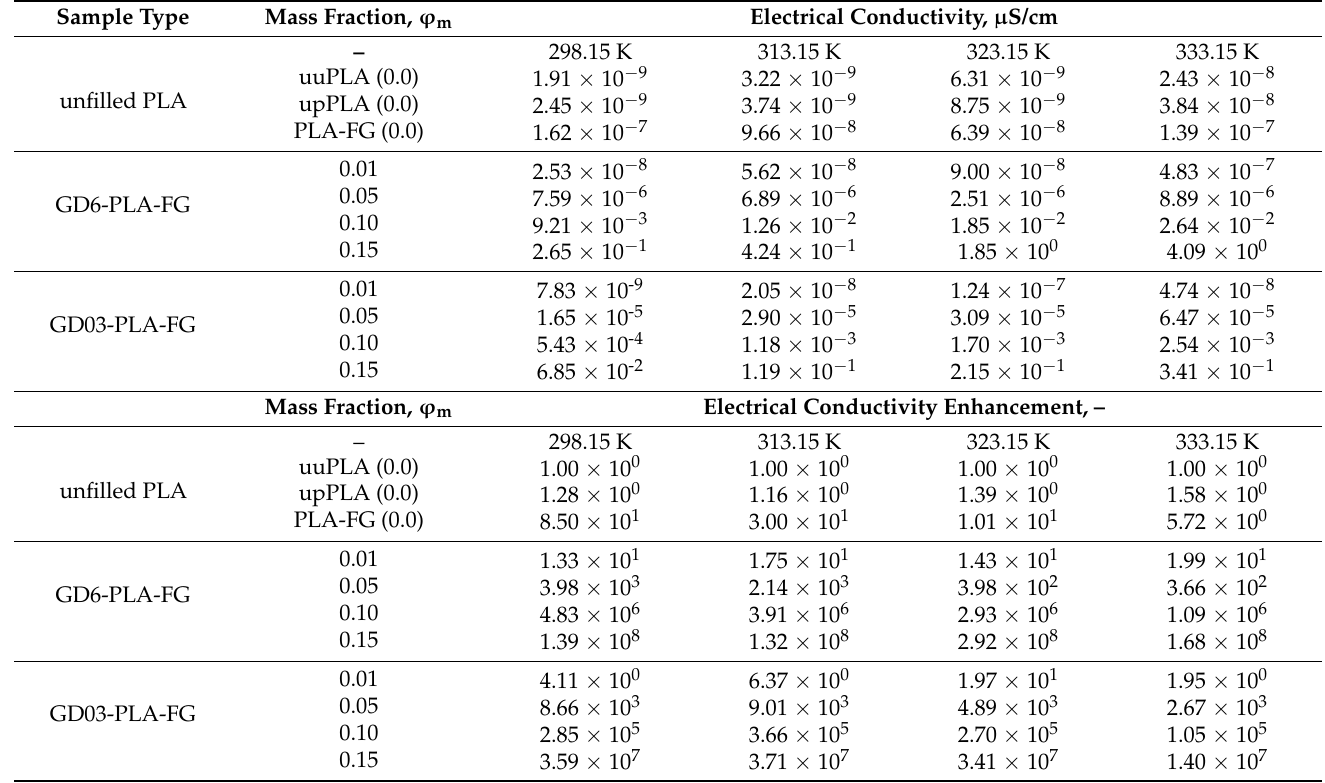
Table 1. Electrical conductivities and their enhancements designated as the ratio of conductivity at 0.1 Hz of the specimen to the conductivity of uuPLA in each temperature for two types of the graphite/diamond mixtures PLA nanocomposites.